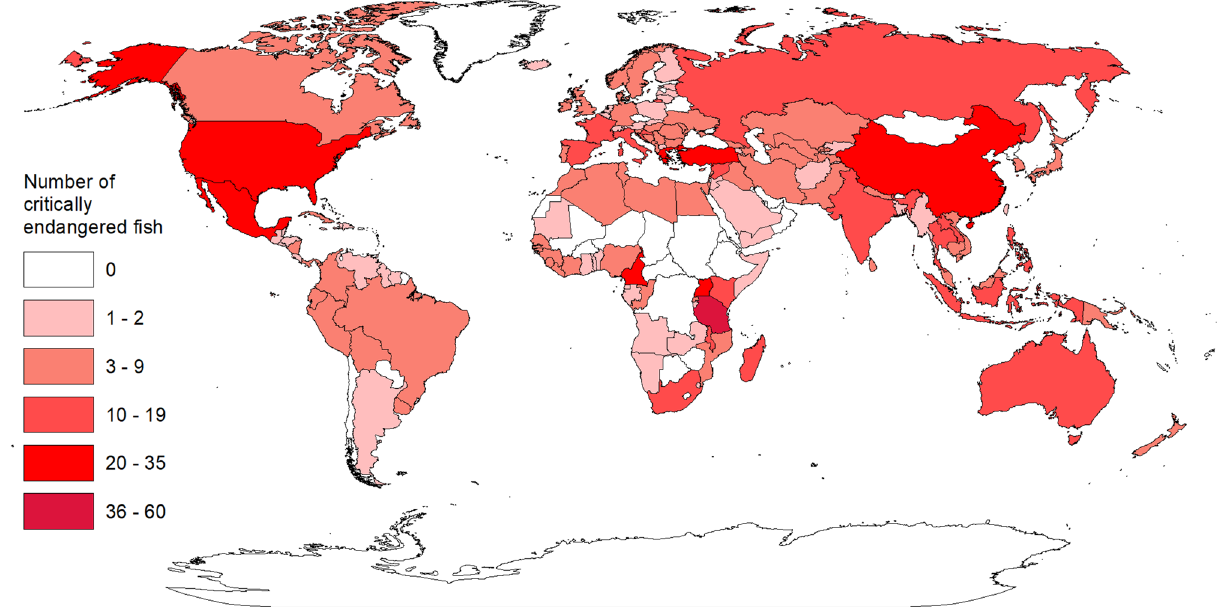
Figure 3. Number of critically endangered fish by country. Data were summarized from the International Union for Conservation of Nature (IUCN) Red List in 2018 for 460 critically endangered fishes. Figure was created using ArcMap (version 10.7.1 & URL: https:// www. esri. com/ en- us/ home) and the outline of countries was acquired from the ArcGIS Hub (URL: https:// hub. arcgis. com/ datas ets/ a21fd b46d2 3e4ef 896f3 14752 17cbb